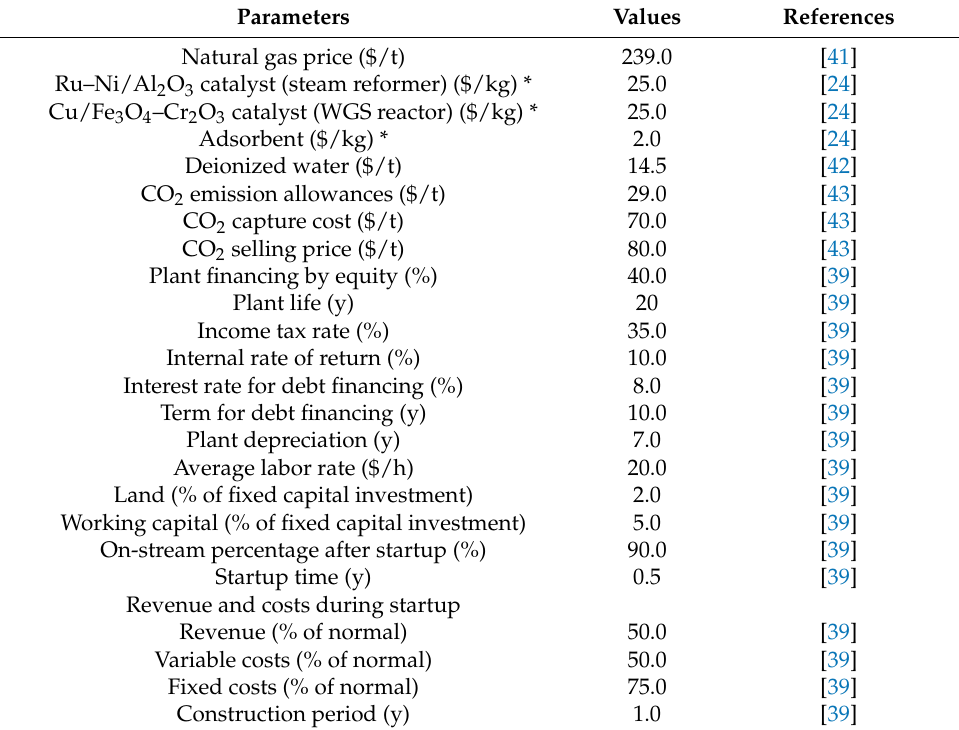
Table 3. Major economic parameters and